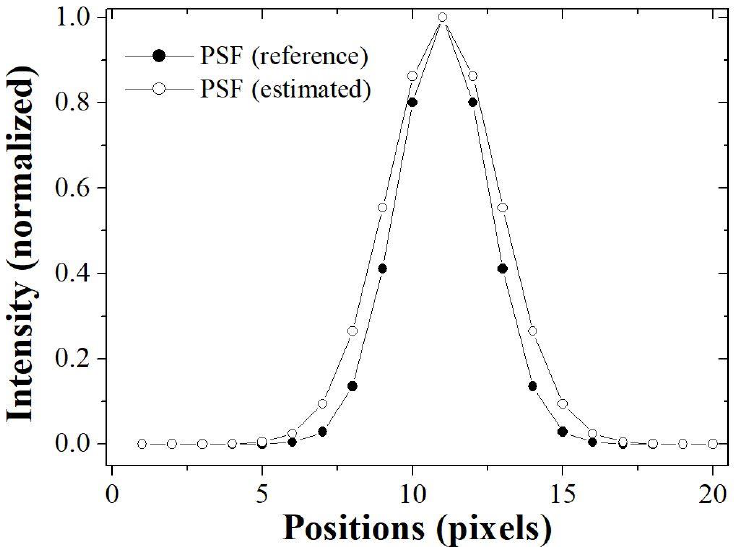
Figure 8. Profiles of the PSF (reference) and PSF (estimated) images measured along the line AB in the Figure 7.